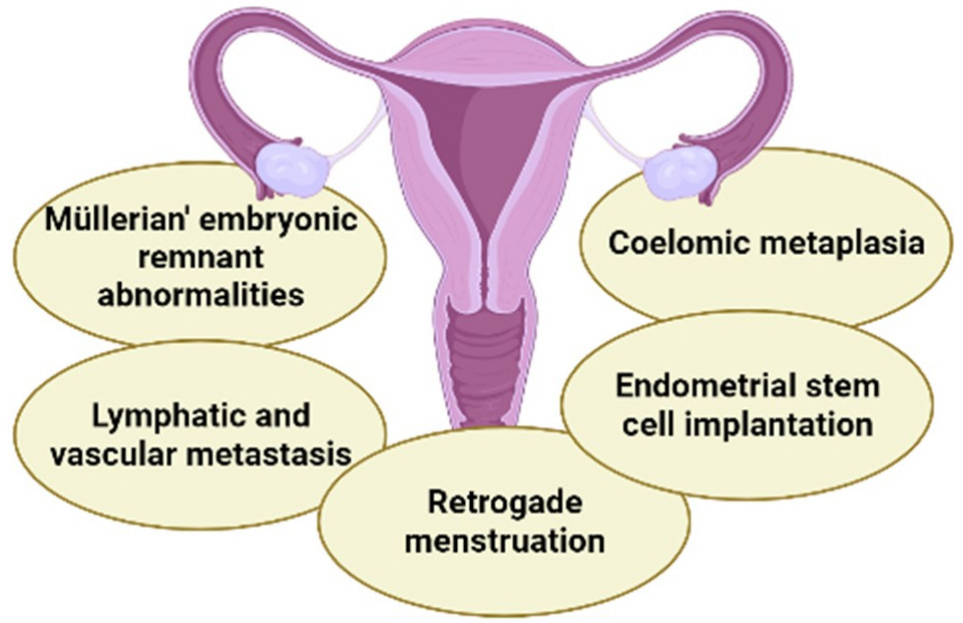
Figure 2. The five main theories explaining endometriosis: Müllerian’ embryonic remnant abnormalities; lymphatic and vascular metastasis; coelomic metaplasia; endometrial stem cell implantation; and retrograde menstruation. Figure created in BioRender.com.